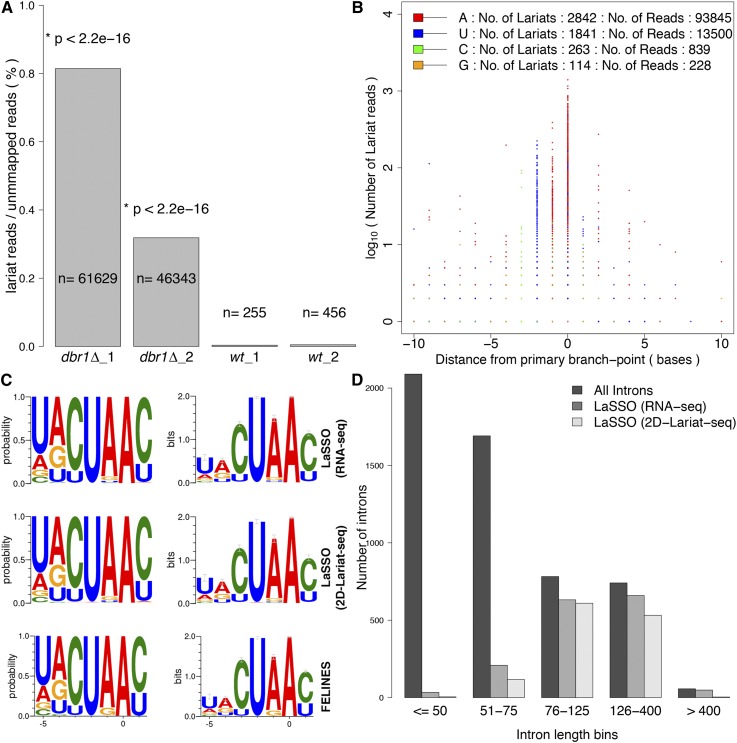
Characterization of lariat branch points and branch-site sequence. (A) Proportion of lariat reads relative to total number of reads not mapped to genome or transcriptome. Absolute numbers in each sample are indicated, along with P-values (Fisher’s exact test). (B) The base (color-coded as indicated) and position (x-axis) of each branch point identified as a function of read number supporting it (y-axis). The primary branch point is placed at position zero on the x-axis. The numbers of lariats and supporting reads are indicated on top. Only branch points located within 10 bases up- (negative values) or downstream (positive values) from a primary branch point are shown. (C) Consensus branch-site sequences around the primary branch point as probability (left) and bits (right), plotted using WebLogo (Crooks et al. 2004) (default settings except for compositional adjustment, with GC content set to 30%). (Top panels) Using LaSSO based on 1236 introns from our data; (middle panels) using LaSSO based on 930 introns from 2D-Lariat-seq data (Awan et al. 2013) that were supported by ≥3 lariat reads; (bottom panels) using FELINES for the same set of 1236 introns detected in this study. (D) Number of introns of different sizes for which lariat reads were detected by LaSSO when no read-number threshold was applied: 1584 lariats for our data, 1268 lariats for 2D-Lariat-seq data by Awan et al. (2013). Introns were binned according to their size as indicated (5361 introns in total).